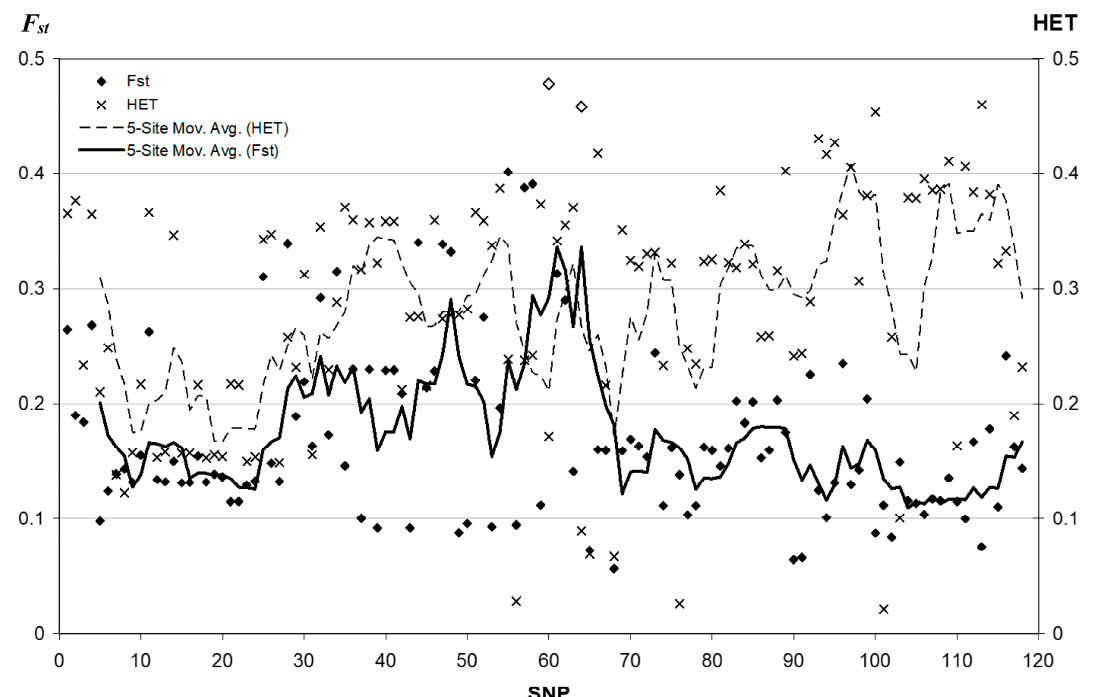
Figure 3. The heterozygosity (HET) and F st (Sewall Wright’s fixation index) of each genetic marker. Most markers have moderate heterozygosity with only three below 0.05. The 5-site moving average curve of heterozygosity suggests a level of 0.2 to 0.4. The two highest F st values marked by the empty diamond symbols are ADH1B Arg48His/rs1229984 and rs3811801. The 5-site moving average curve of F st values, drawn as a solid line, peaks around those two SNPs. The F st of ADH1B Arg48His is 3.61 SDs (standard deviation) above the mean, while that of rs3811801 is 3.38 SDs above the mean. Three nearby SNPs, #55 = rs1042026 ( F st = 0.401), #57 = rs2066701 (the Rsa I restriction site) ( F st = 0.388), and #58 = rs2075633 ( F st = 0.391), have F st values > 2.5 SD above the mean.